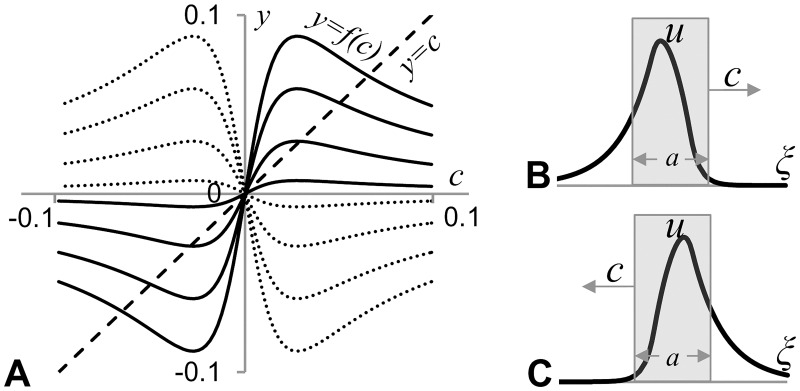
Travelling wave solutions in the system (2, 4).A: Plots of y = f(c) for four positive (dotted lines) and four negative (solid lines) values of c0 and the plot of y = c (dashed line) are shown. Abscissa of the points of intersection of solid/dotted lines with dashed one gives the speed, c, (for the value of c0 corresponding to the solid/dotted line) satisfying Eqs (3) and (5). Points of intersections in the first quadrant are associated with the segment moving to the right (c>0), while the points of intersection in the third quadrant (c<0)–to the left. Model parameters used for plotting solid lines: k1
= 2.5*10−4, k2
= 2*k1, D = 0.5; a = 50, c0
= -12,-8,-4,-1—for (highest to lowest in the II quadrant) dotted lines and c0
= 1, 4, 8 and 12—for (lowest to highest in the I quadrant) solid lines. B: u-profile for the segment moving to the right (given by the Eq (3) where c = 0.02). C: u-profile for the segment moving to the left (given by the Eq (3) where c = -0.02).